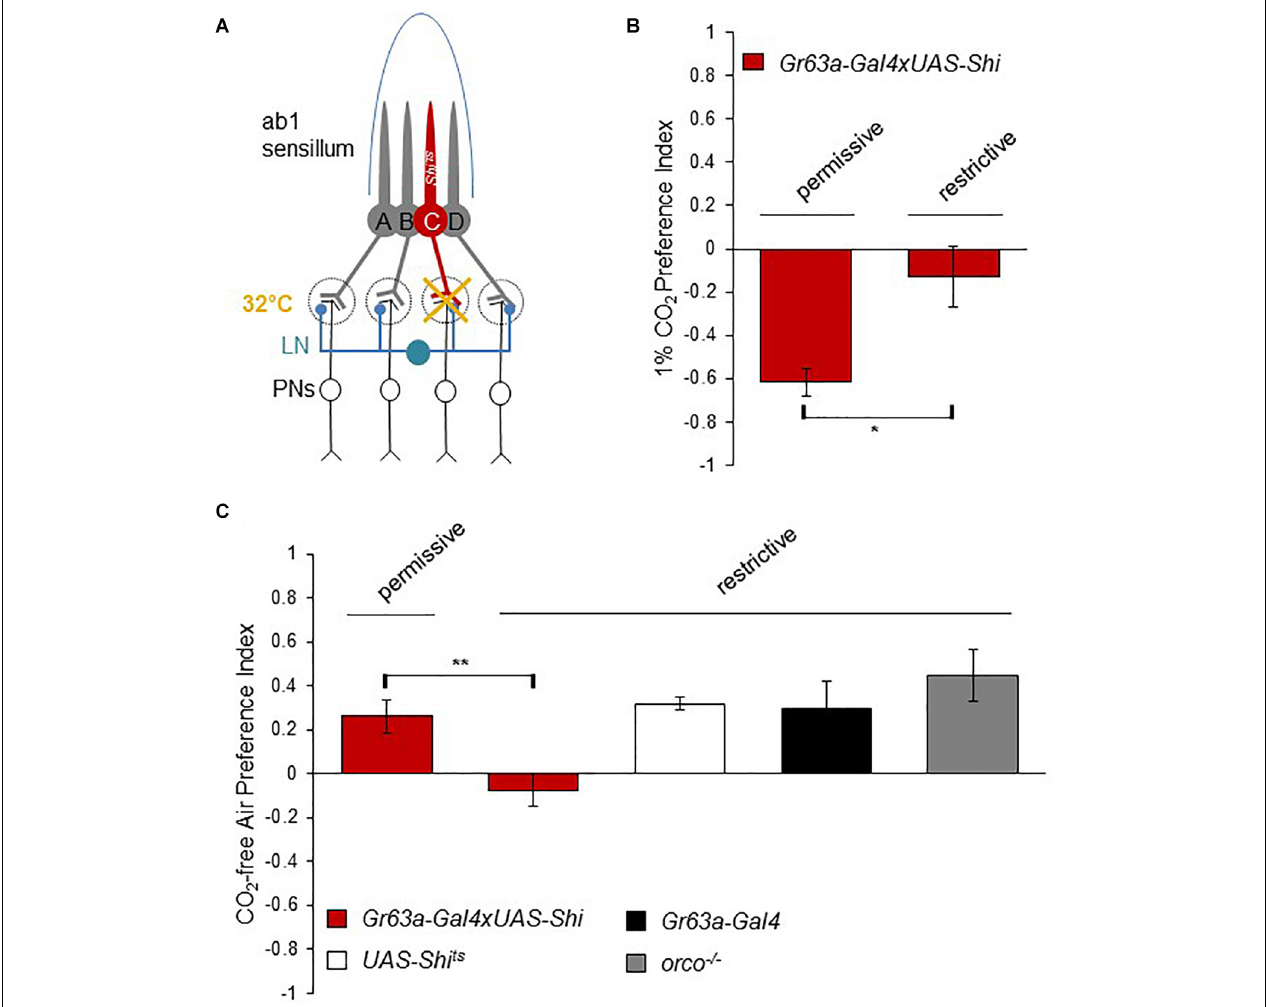
FIGURE 2 | Synaptic release from the CO 2 neuron is necessary to detect sub-atmospheric CO 2 . (A) Neuronal composition of the ab1 sensillum. Neuron C represents the CO 2 receptor neuron (ab1C) expressing UAS-shi ts1 under the control of a Gr63a-Gal4 driver. Synaptic output of ab1C neurons was blocked by shifting flies to 32 ◦ C (restrictive) and compared to the behavior of flies tested at 25 ◦ C (permissive). (B) Response of Gr63a > shi ts1 flies to CO 2 under permissive and restrictive temperatures. Blocking ab1C neuron output under restrictive temperature reduced CO 2 avoidance significantly ( p = 0.025, n = 6) compared to permissive controls ( n = 4). (C) Response of Gr63a > shi ts1 flies to CO 2 .-free air at restrictive and permissive temperature. Similar to their loss of aversion to CO 2 , flies under restrictive temperature conditions were not attracted to CO 2 .-free air compared to controls ( p = 0.0099, n = 8). Gr63a > shi ts1 flies under the permissive temperature ( n = 6) as well as UAS-shi ts1 ( n = 8), Gr63a-Gal4 ( n = 4), and orco 1 / 1 ( n = 8) controls showed attraction to CO 2 .-free air. Significance assessed by T-test. Error bars represent SEM. (ns > 0.05, * p ≤ 0.05, ** p ≤ 0.01, *** p ≤